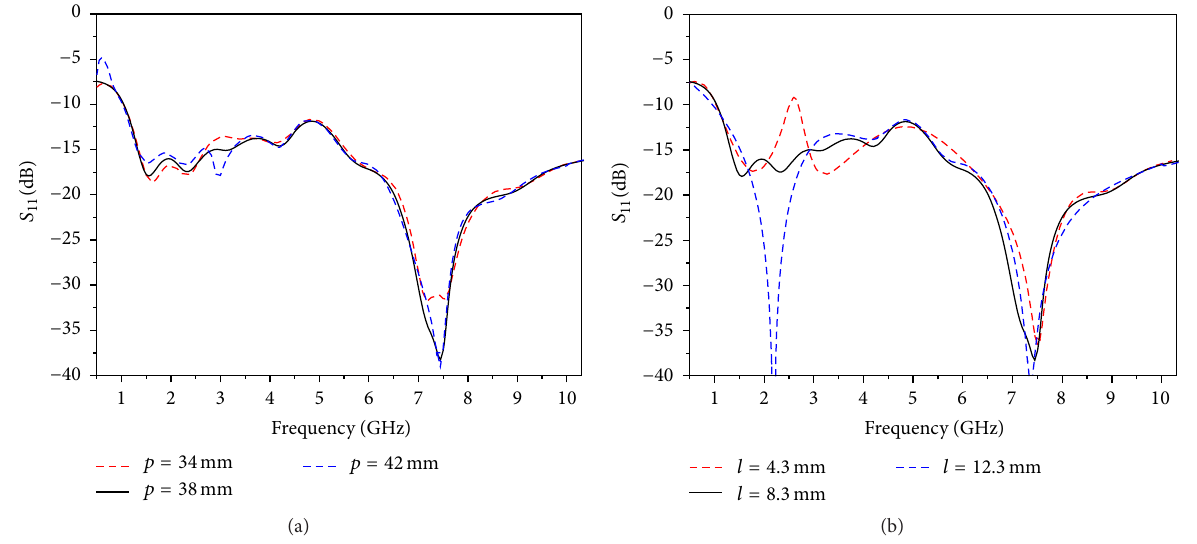
Figure 3: Simulated return loss of proposed antenna at (a) height of the arc and (b) length of the arc.